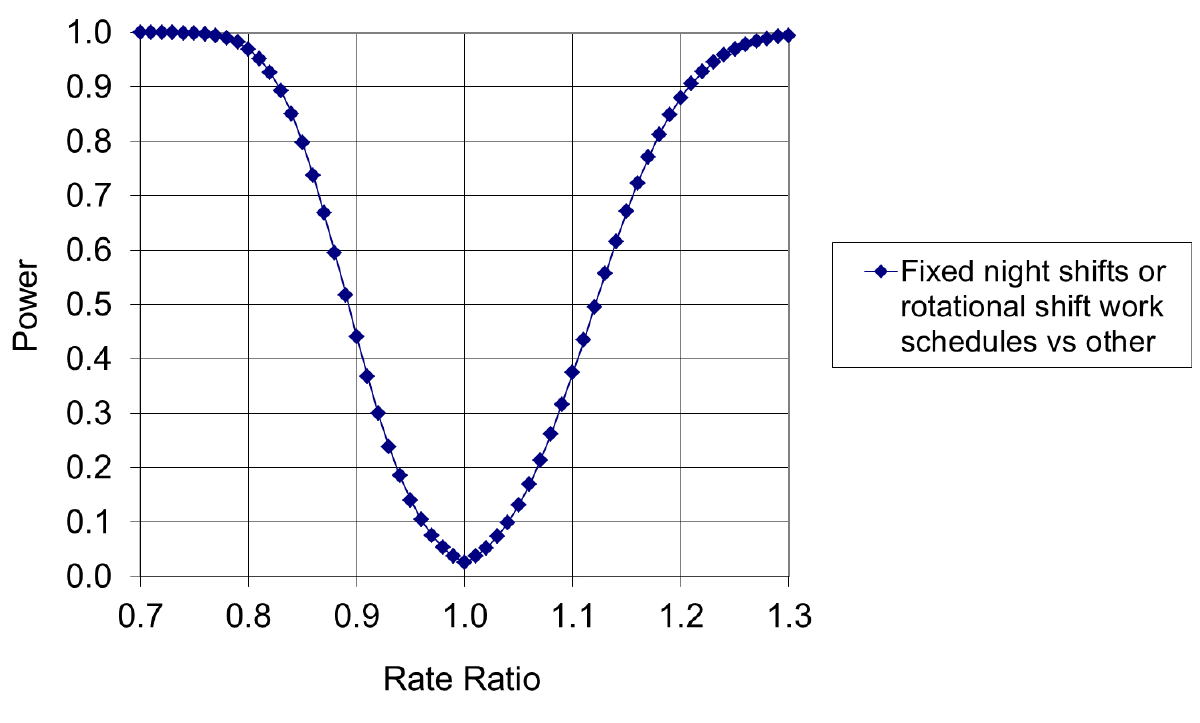
Figure 2. Power of detecting differences in psychiatric morbidity rates in Denmark, between employees on fixed night shifts or rotational shift work schedules and employees with other work schedules, as a function of the true rate